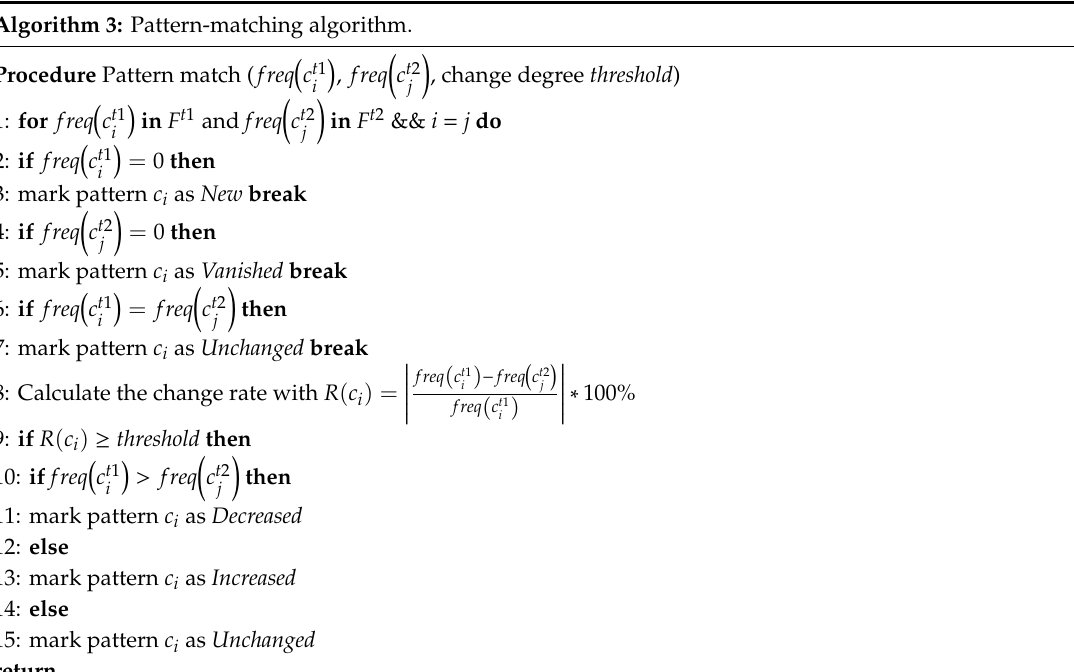
Algorithm 3: Pattern-matching